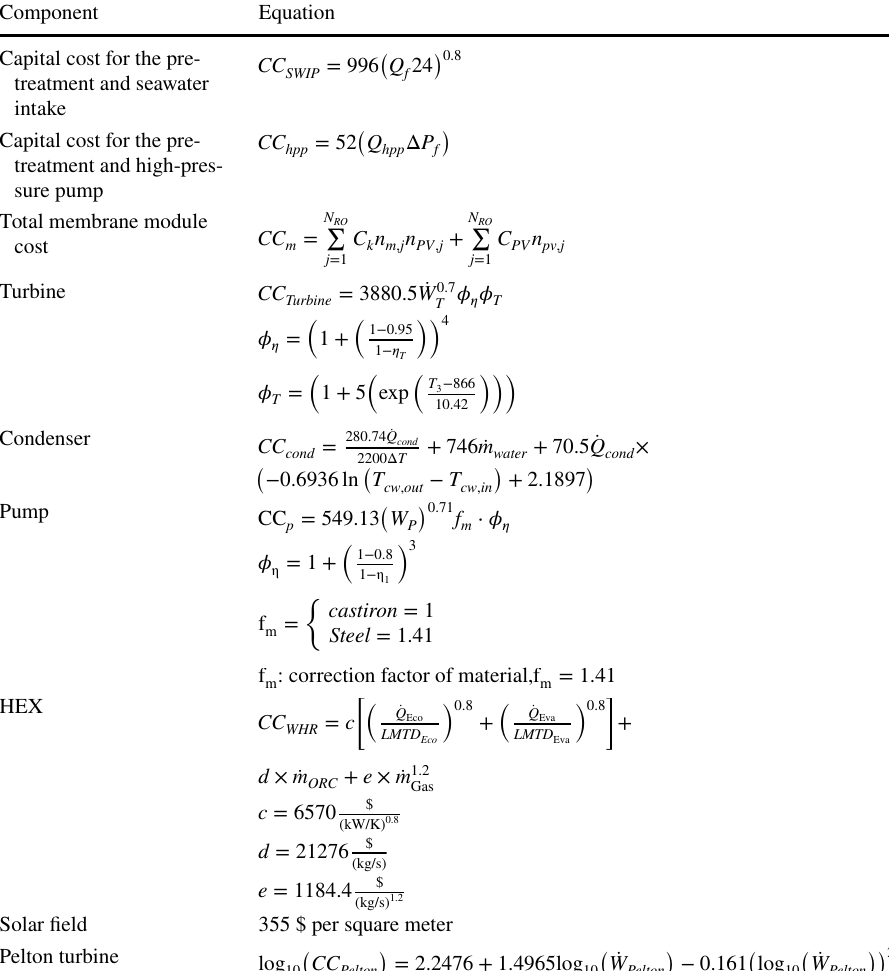
Table 5 The equations for estimating the cost components